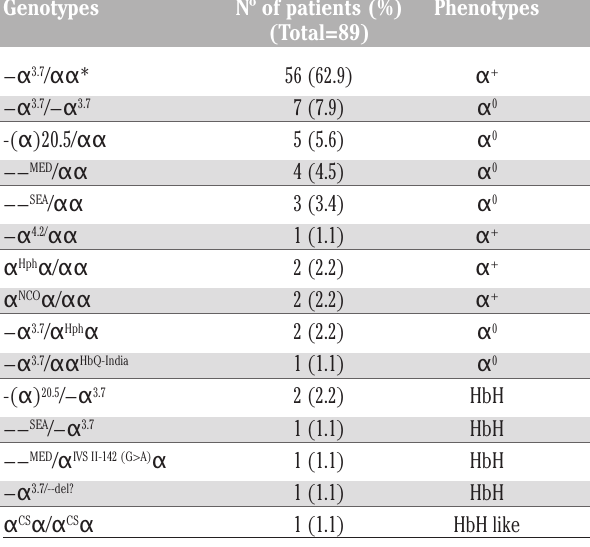
Table 2. Percentage of patients with alpha thalassemia, genotypes and